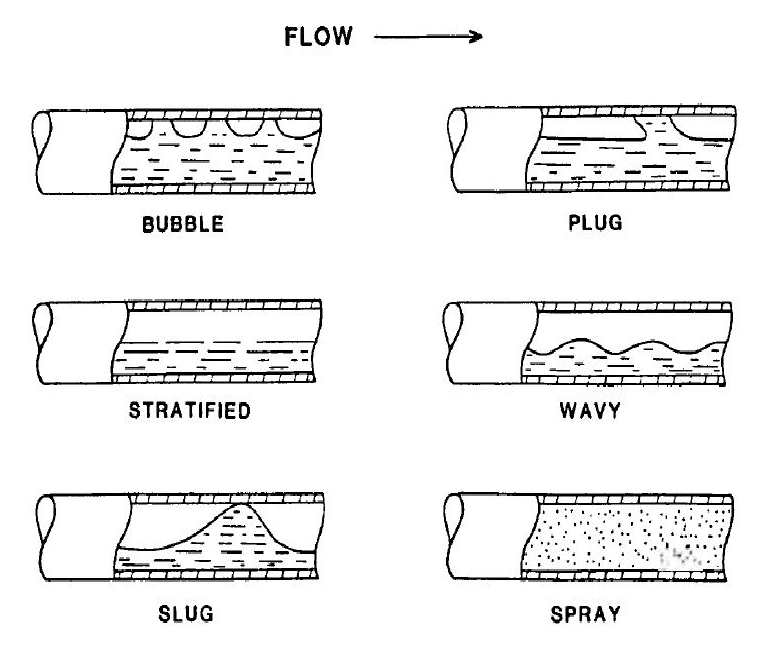
Figure 4. Two-phase flow pattern, adapted from [44]. The 2D horizontal channel and corresponding mesh used in the validation tests are shown in Figure 5a,b, respectively. The mesh grid is generated via the OpenFOAM mesh generation tool, blockMesh .